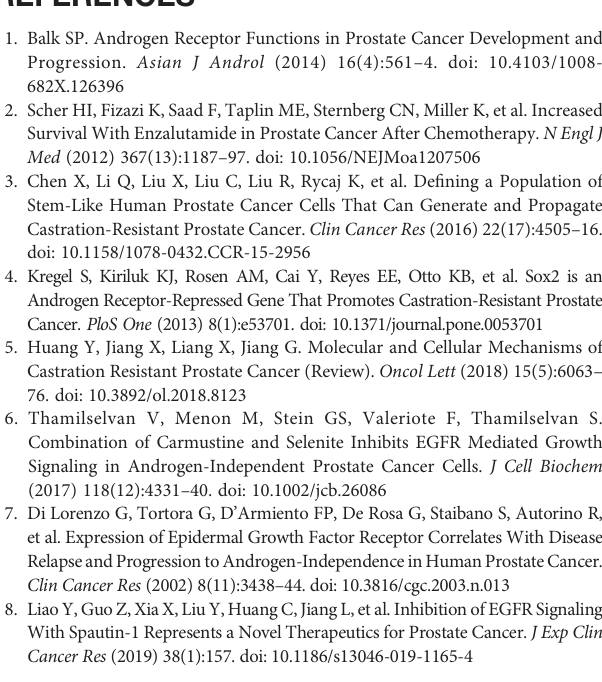
Supplementary Figure 2 | Relationship between KIF15 and EGFR level in prostate cancer cells. (A) GSEA analysis of EGFR signatures (down-regulated after treatment with EGFR inhibitor) from a microarray dataset (GSE2443) that pro fi led with KIF15_High (the highest 2 samples) or KIF15_Low (the lowest 2 samples) expression. NES = 2.57; P < 0.0001, FDR q < 0.0001. (B, C) The protein (B) and mRNA (C) expression of EGFR determined by Western blot and qRT-PCR analysis after KIF15 transient knockdown in PC3 cells. PC3 cells were transfected with corresponding siRNA for 72 hours, then were harvested and lysed for Western blot assay (B) . PC3 cells were transfected with corresponding siRNA for 48 hours. The total RNA was extracted, and the mRNA levels of KIF15 and EGFR were then determined by qRT-PCR (C) . * P <0.05, ** P < 0.01, *** P <0.001. (D) EGFR and KIF15 protein expression levels examined by Western blot in LNCaP cells. LNCaP cells were transiently transfected with the indicated expression plasmids and/or siRNA for48 hours.Thecellswerethenharvested andlysed for Westernblotassay. (E) EGFRandKIF15proteinexpressionlevelsexaminedbyWesternblotafterKIF15 siRNA knockdown in 22Rv1 cells. 22Rv1 cells were transiently transfected with corresponding siRNA for 72 hours. The cells were then harvested and lysed for Western blot